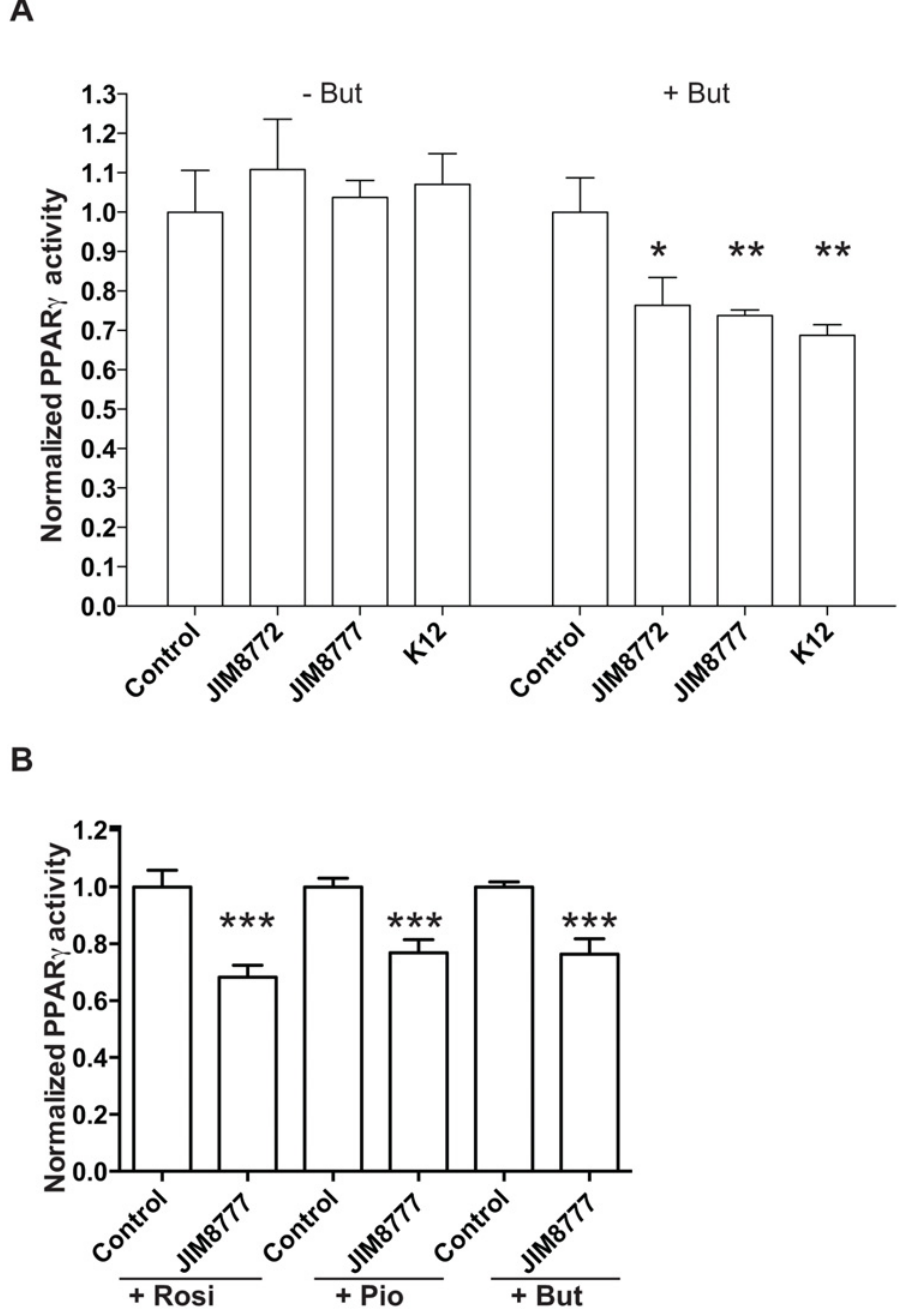
Fig 3. The S . salivarius – dependent down-regulation of PPAR γ activity is independent of the epithelial cell-line or the specific PPAR γ -ligand used. A- PPAR γ was activated (+ But) or not (- But) in Caco-2 reporter cells (Caco2-PPAR γ ) using sodium butyrate (2mM) in the presence of control medium (Control) or supernatants. B- HT-29-PPAR γ reporter cell-line was activated with different activators: rosiglitazone (Rosi, 10 μ M), pioglitazone (Pio, 10 μ M) and sodium butyrate (But, 2mM) in presence of S . salivarius JIM8777 supernatant. The values represent the luciferase activity normalized towards their respective control. Data are expressed as means ± standard deviations (SD) of triplicate measurements from one representative experiment out of three independent experiments. *** P < 0.001, ** P < 0.005, * P < 0,05 compared with controls (Student's